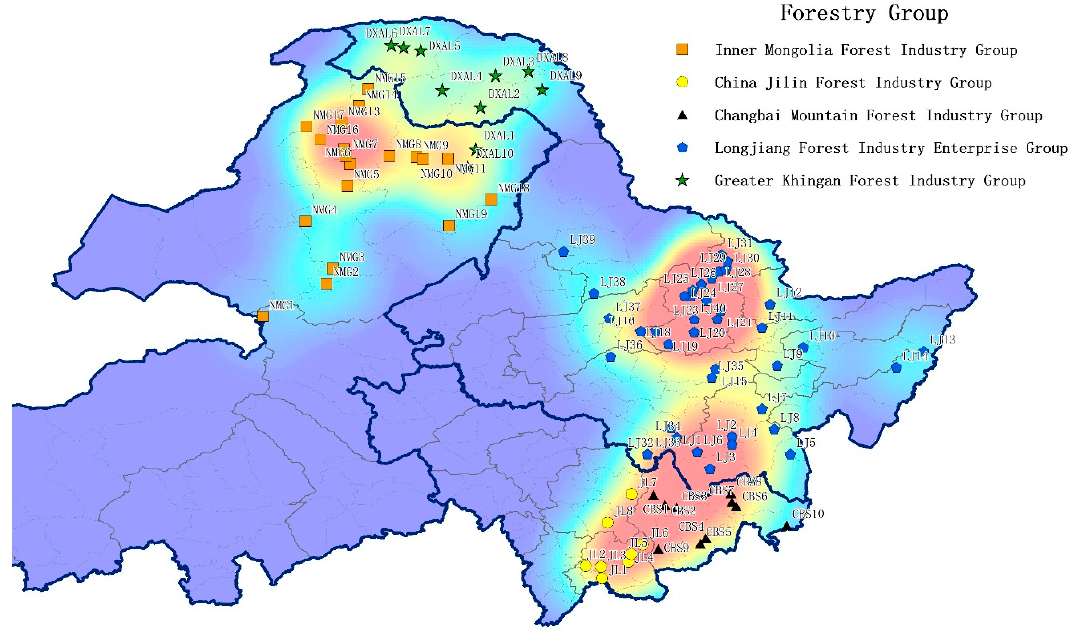
Figure 2. Distribution of 87 SOFEs in study site.